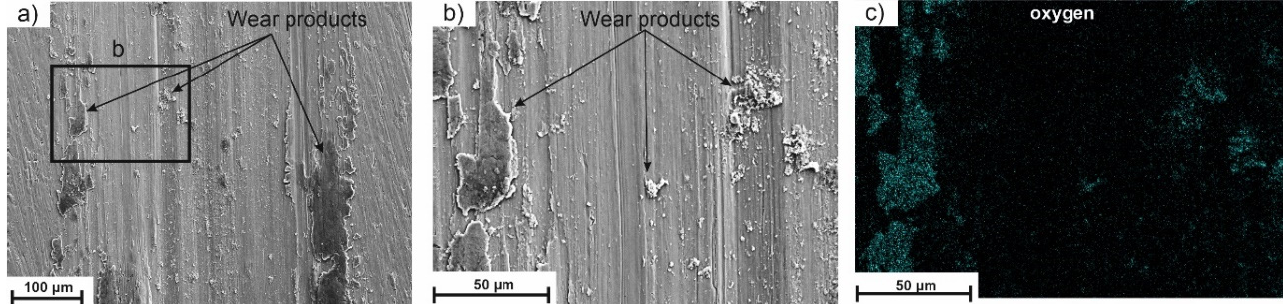
Figure 49. Comparison of wear rate for AM fabricated and as-cast BMGs and two crystalline alloys, [32,34,50,57,178–180].